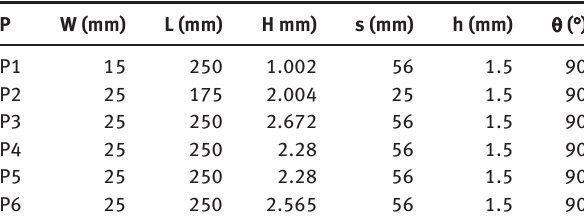
Table 1: Geometric size of the specimens.